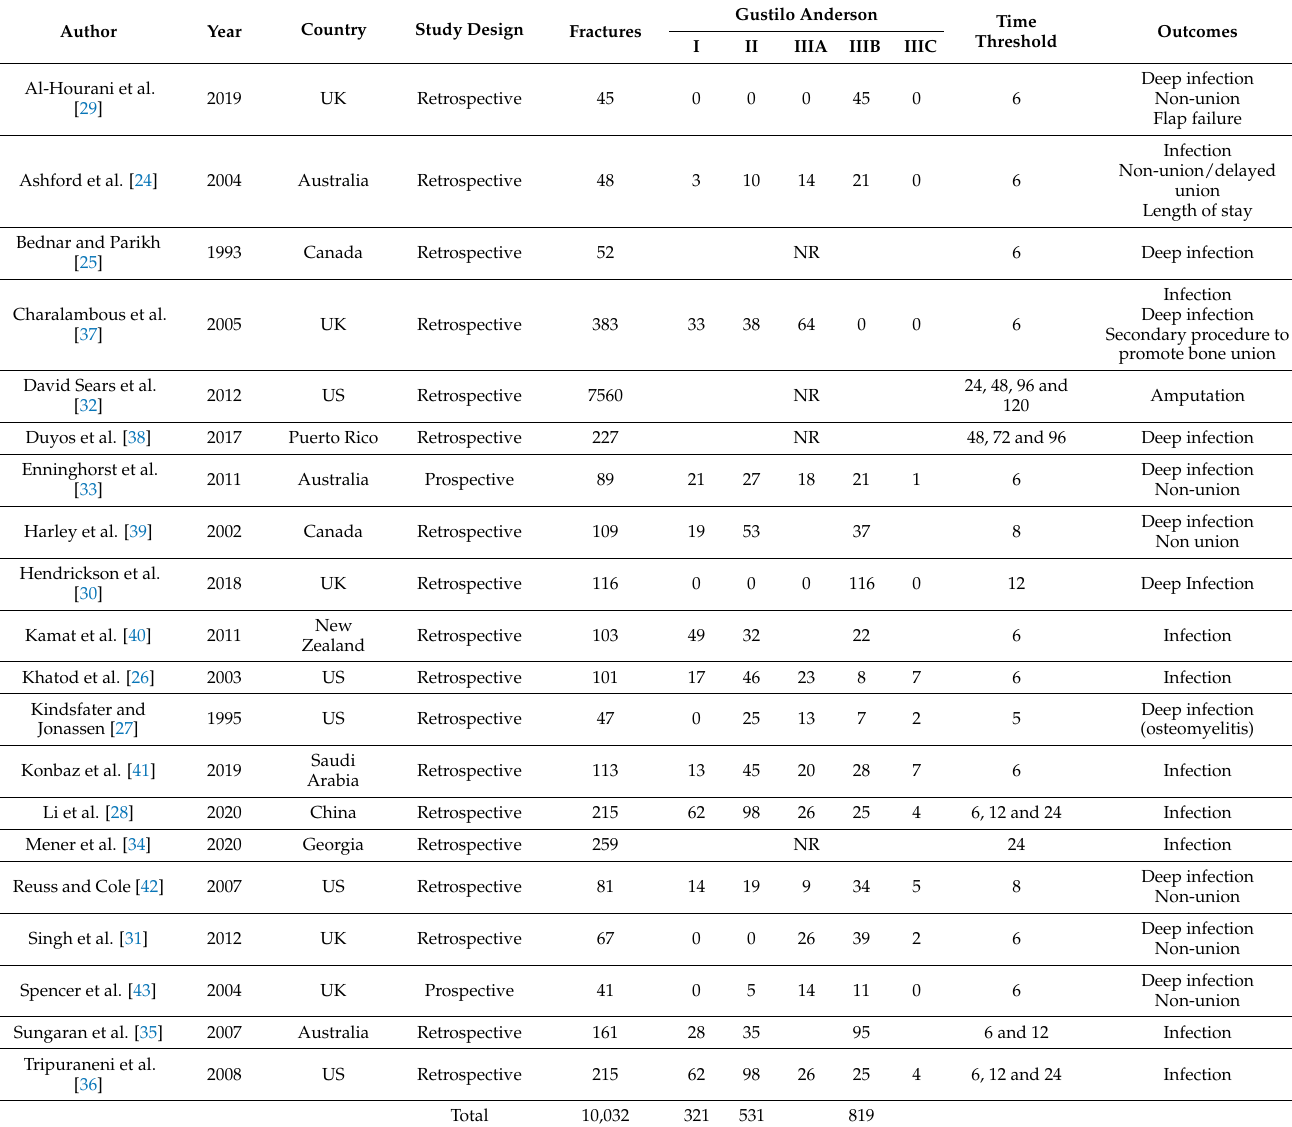
Table 1. Summary of characteristics of included